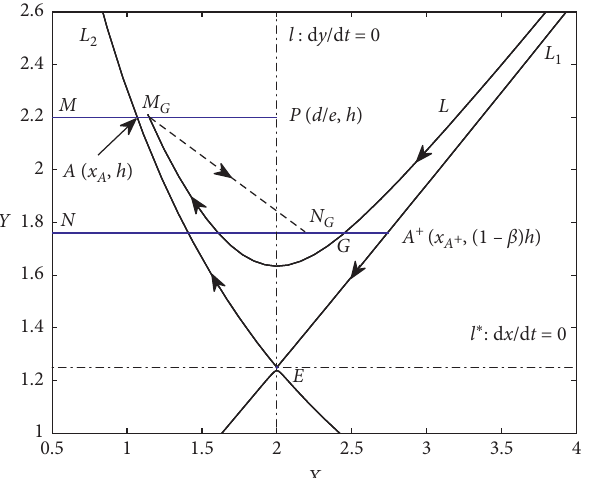
Figure 2: Diagram of state feedback impulsive system with pa- rameter values: a � 5 , c � 4 ,d � 6 ,e � 3 , h � 2 . 2, and β � 0 .